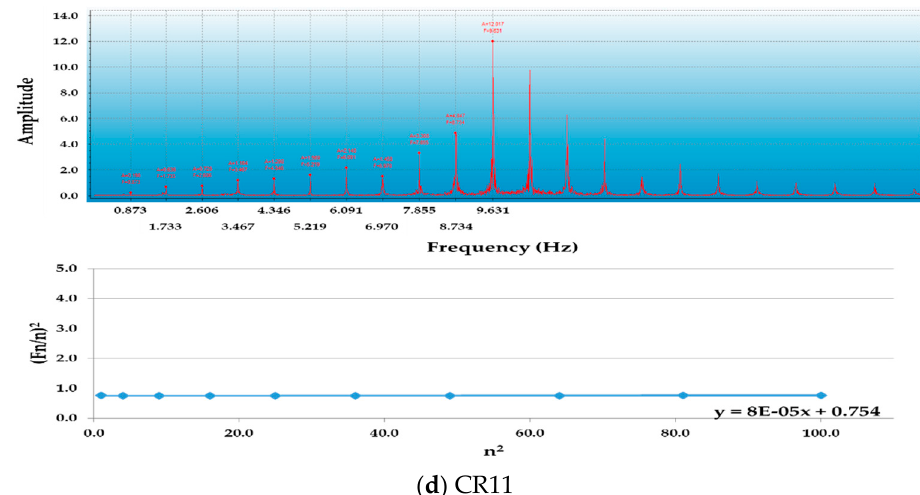
Figure 6. Cable tension force estimation result. ( a )–( d ) Cable tensile force in corresponding positions.